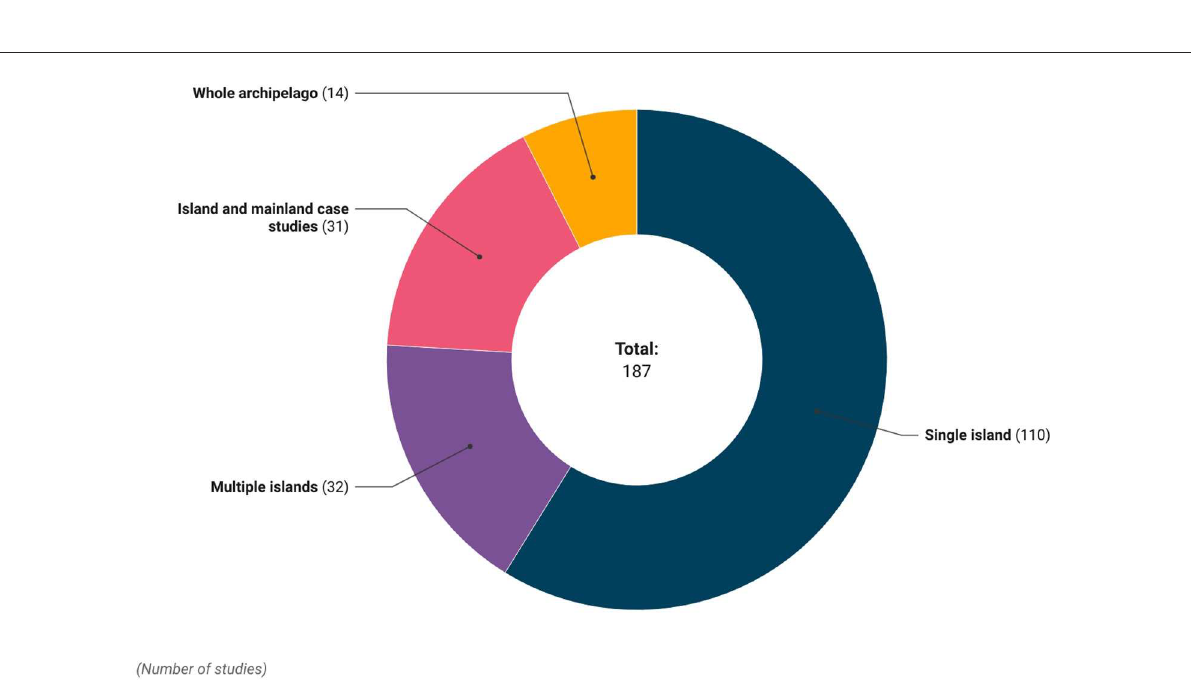
FIGURE2 Distribution of articles per study